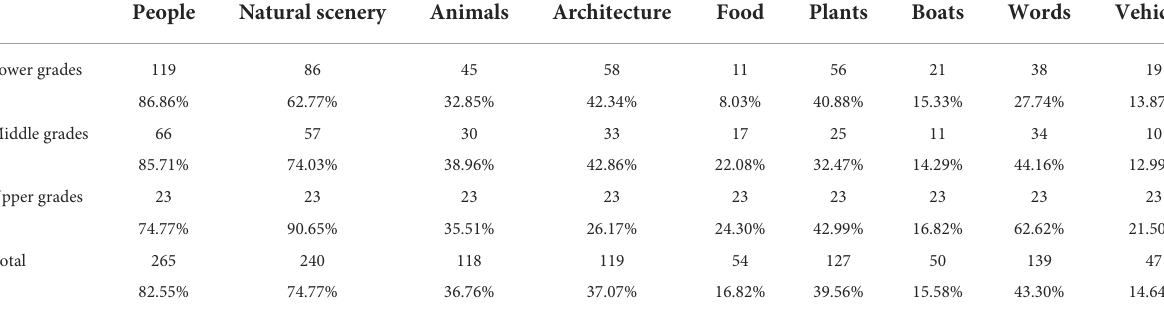
TABLE 3 Statistical analysis of tourism elements in children’s drawings.